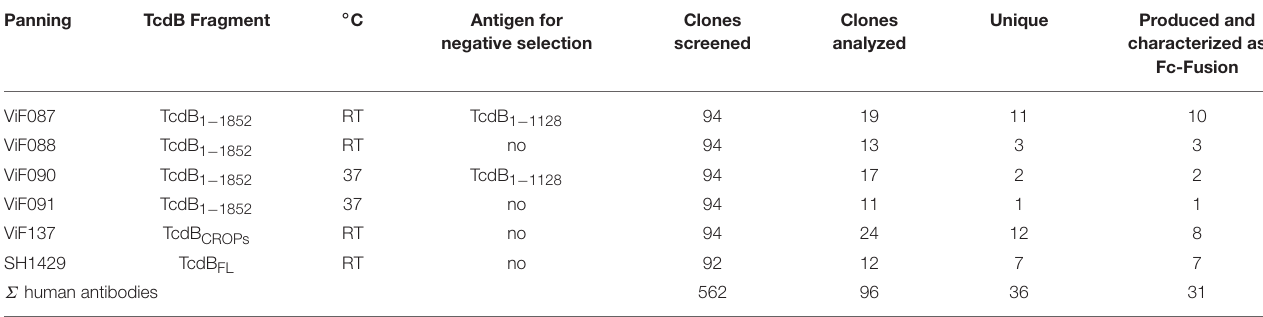
TABLE 1 | Panning